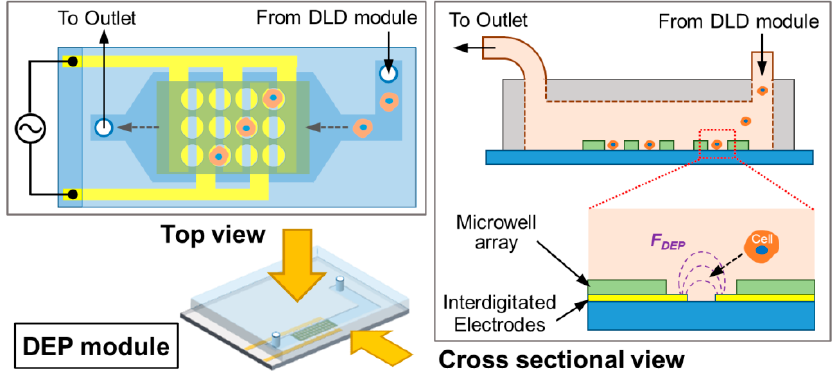
Figure 6. Schematic illustration of the DEP module using electroactive microwell array (EMA).